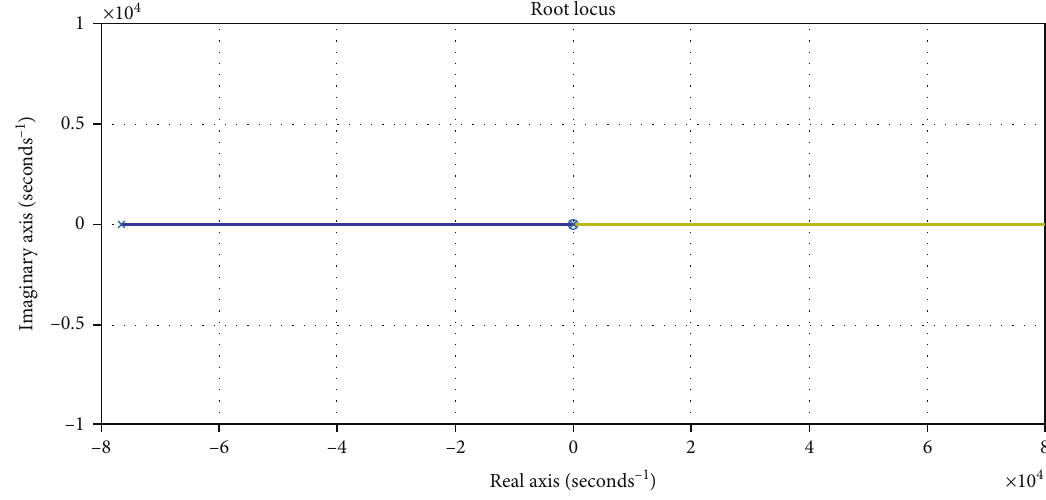
Figure 6: The Bode plot of the transfer function sys .